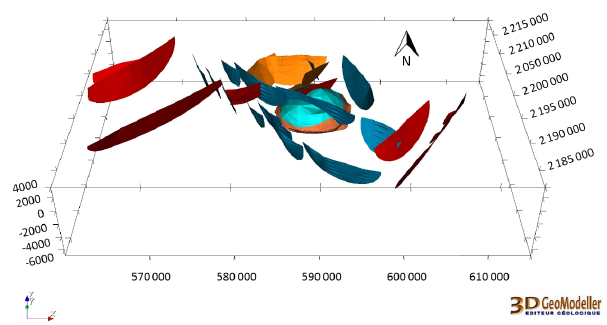
Figure 15. The Acoculco regional geological model. Five groups of geological formations are modelled from the geological map and two wells (Fig. 7), and the two main interpreted cross-sections AA’and BB’ (see Fig. 13). Coordinate system is WGS84/UTM zone